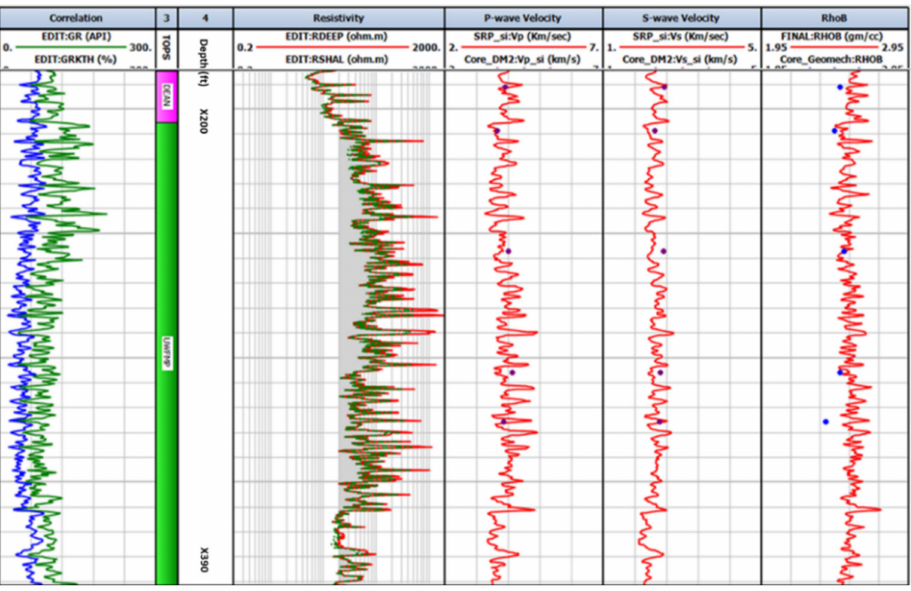
Figure 15. Log plot of the Wolfcamp shale formation—Midland basin. The GAMMA RAY track contains Gamma-ray (green curve) and spectral gamma-ray (blue curve). The RESISTIVITY track contains resistivity log. The P-wave velocity track contains sonic P-wave velocity (red curve) and ultrasonic P-wave velocity (purple discrete data points). The S-wave velocity track contains sonic S-wave velocity (red curve) and ultrasonic S-wave velocity (purple discrete data points). The RhoB track contains log measured bulk density (red curve) and core measured bulk density (blue discrete data). Depths in the depth track are only to indicate depth scale; actual depths are not available for